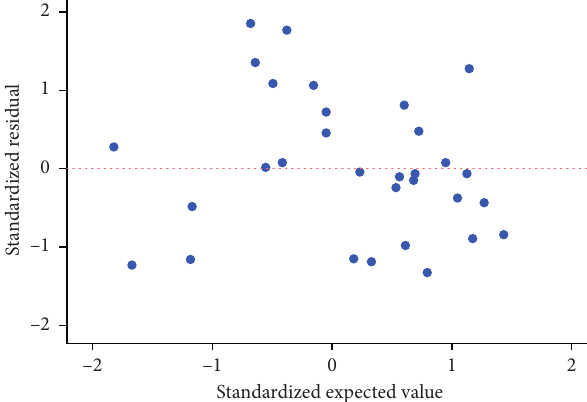
Figure 6: Plot for the standardized